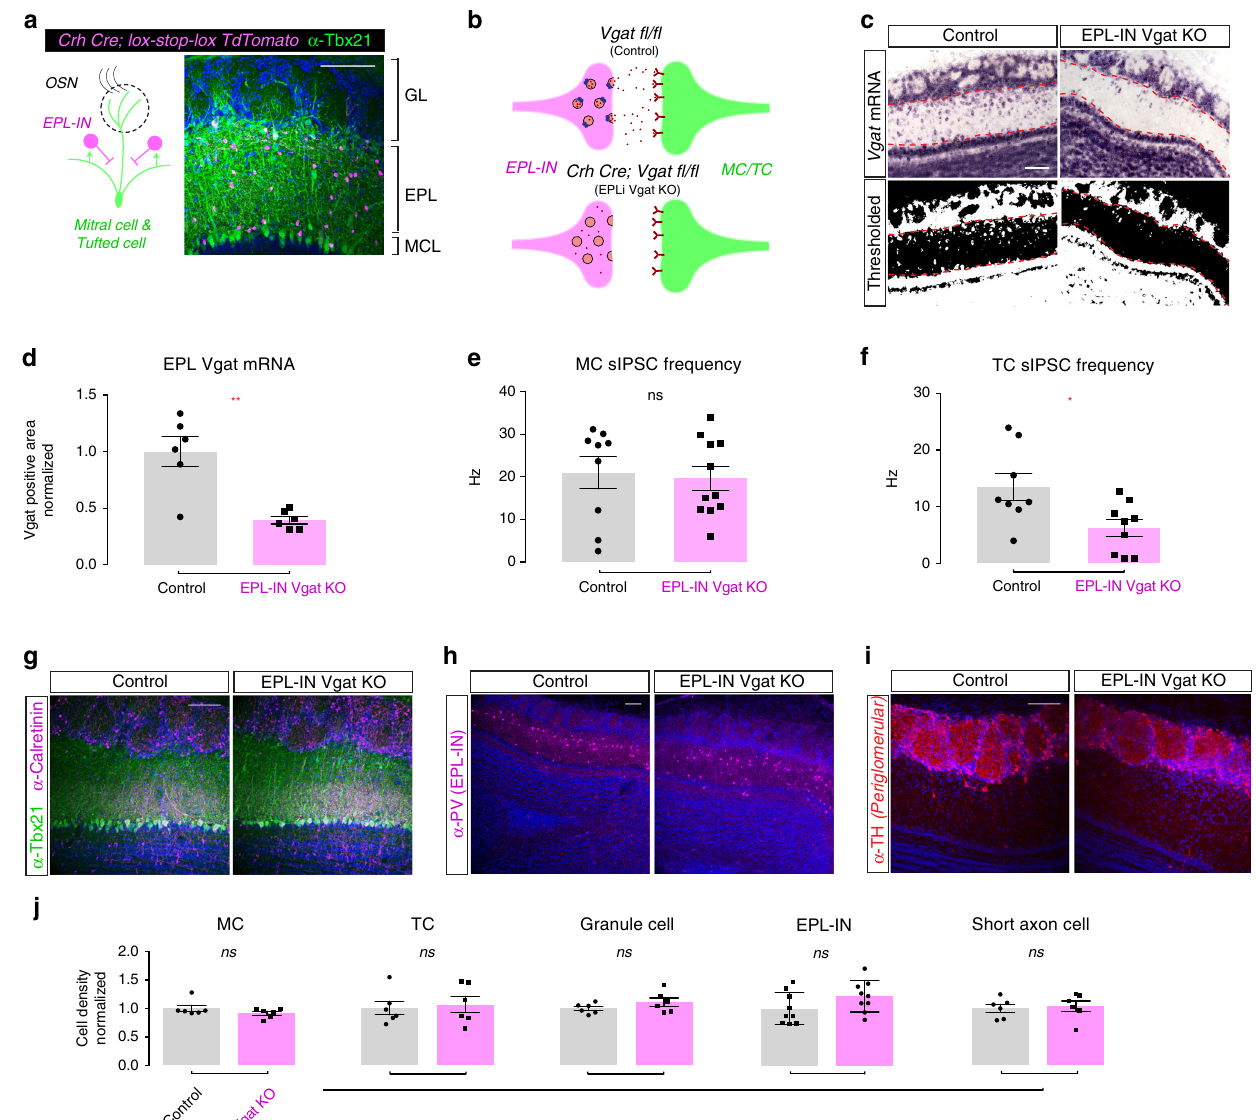
Fig. 1 Olfactory bulb architecture is preserved in EPL-IN Vgat knockouts. a Illustration of OB connectivity (left). OB coronal section (right) with TdTomato positive EPL-INs (magenta) and anti-Tbx21 positive TC/MC (green) in the EPL and MCL layers. b Illustration depicting normal Vgat protein function for neurotransmitter vesicle loading (Top) and after excision of the Vgat fl ox/ fl ox allele (Bottom). c Top: In situ hybridization against VGAT mRNA between control and EPL Vgat knockout. Bottom: Thresholded black/white image from top images. d Quanti fi cation of Vgat positive area within the EPL. All areas normalized to the average control area. Two-tailed t -test, ** p < 0.01. e Frequency measurements of sIPSC onto MCs between Control vs EPL Vgat KO. Two-tailed t -test. f Frequency measurements of sIPSC onto TCs between Control vs EPL Vgat KO, Two-tailed t -test, *p < 0.05. g Antibody staining to compare control and EPL Vgat knockout animals for Tbx21 positive excitatory neurons and calretinin-positive inhibitory neurons, h parvalbumin positive EPL-INs, and i tyrosine hydroxylase (TH) positive SACs. j Cell density comparisons (two-tailed t -test) between control and experimental animals for MCs, TCs, GCs, EPL-INs, and SACs. Cell densities normalized to controls. Averages ± SEM. All scale bars 100 μ Odor-evoked TC/MC responses were subsequently used to con- a decrease in fi ring to the most inhibiting odor. These opposing struct normalized response pro fi les for each control and experi- effects led us to investigate the tuning between the two groups. mental cell (Fig. 2c). After sorting each pro fi le by odor response, We fi rst normalized all responses between 0 and 1, relative to the we averaged the pro fi les for both control and experimental minimum and maximum response for each cell, and then groups. averaged the tuning curves for each group to reveal a signi fi cant difference in tuning curve between experimental and control animals (Fig. 2e). KO animals (Fig. 2d, EPL Vgat KO: n = 51 cells across 11 mice, Because fold-change analysis can show inherent biases towards Control: n = 55 cells across 12 mice). Furthermore, we observed lower baseline fi ring cells, we also assayed odor responses by an increase in fi ring in response to the most activating odor, with absolute fi ring change and Z -score, both of which changed